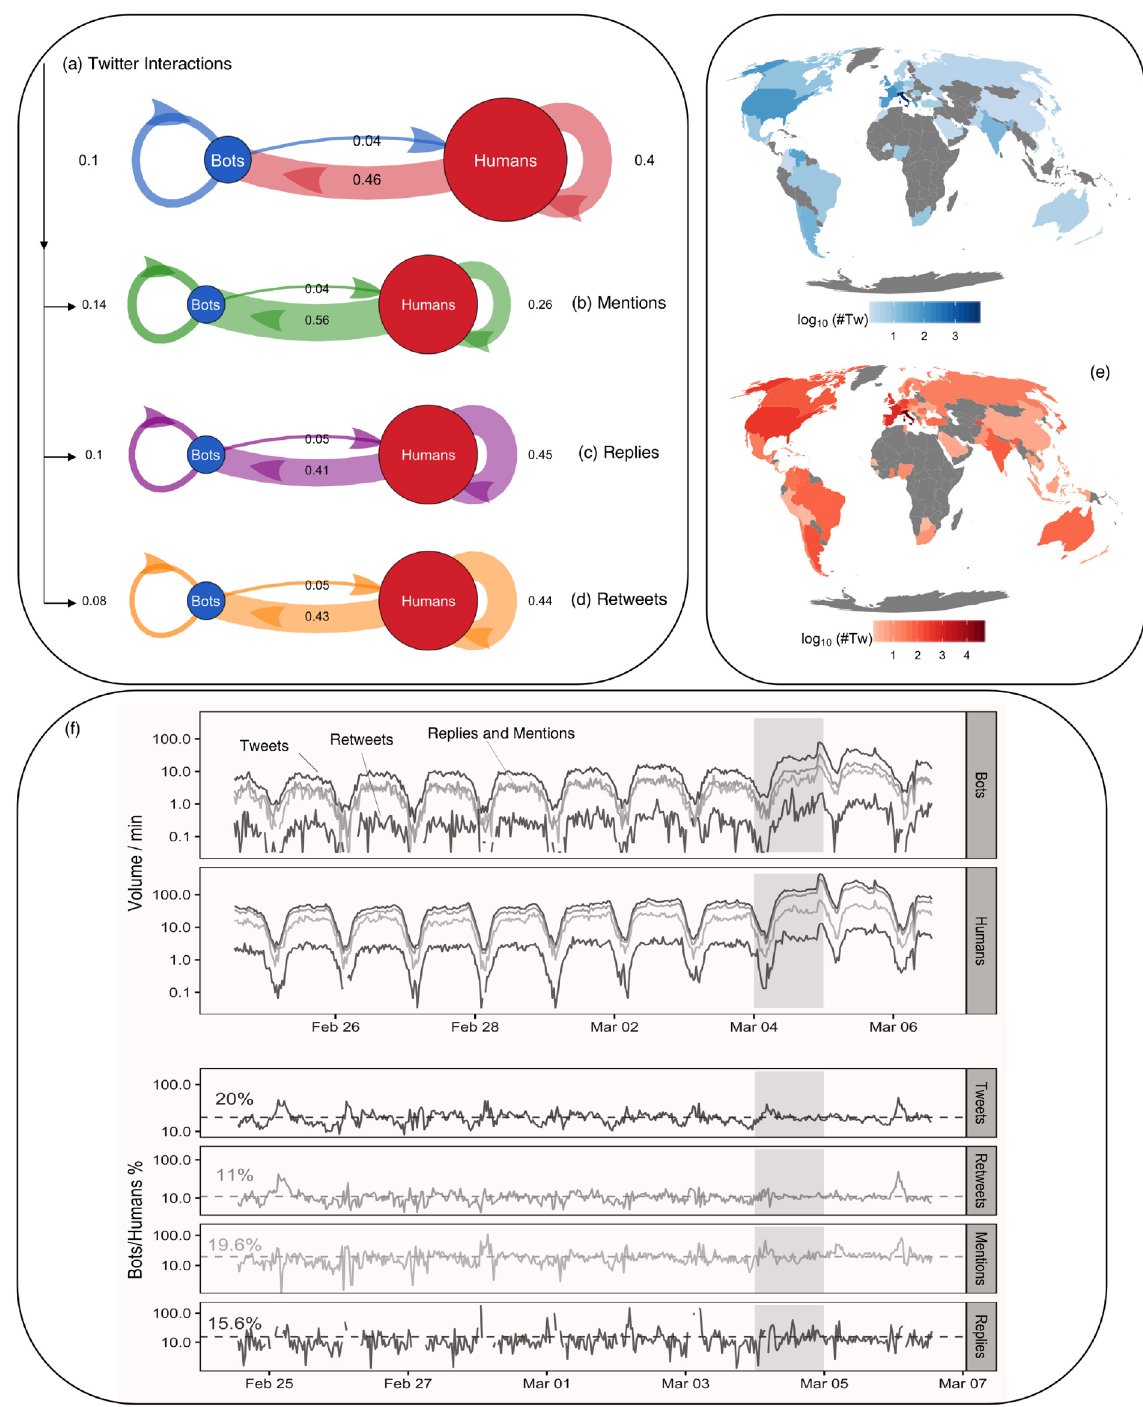
Fig 1. Online human-bot interactions during the Italian elections. (a) : Volumes of human-bot interactions in Twitter. (b-d) : Human-bot interactions stratified by actions: Mentions, Replies and Retweets. (e) : Geographic location of involved users, where the color encodes the number of tweets per country, in logarithmic scale. As in (a), humans are in red and bots are in blue. Users are mostly located in Italy, with relevant interactions from other countries worldwide. (e): Evolution across time of the overall social activity of humans and bots (top), also stratified by actions